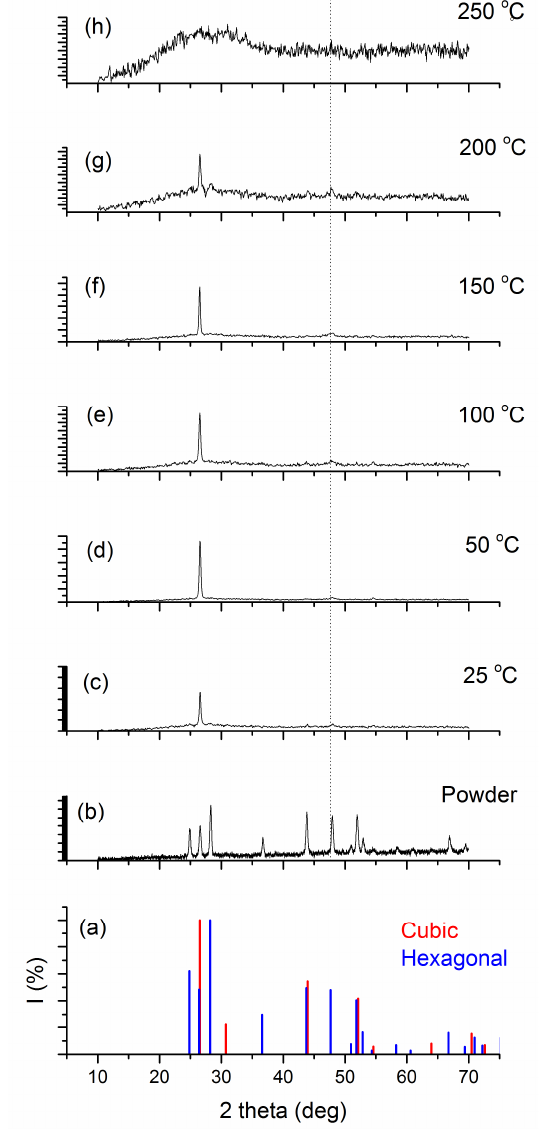
Figure 2. XRD patterns of the ( a ) standard JCPDS cards for hexagonal and cubic structure; ( b ) source CdS powder and vacuum-evaporated CdS thin films deposited at different substrate temperatures: ( c ) 25 °C; ( d ) 50 °C; ( e ) 100 °C; ( f ) 150 °C; ( g ) 200 °C and ( h ) 250 °C.